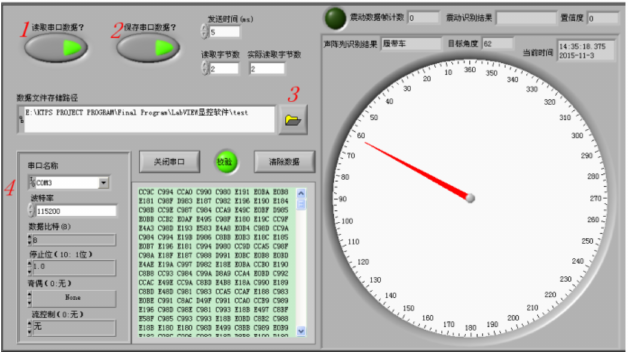
Figure 8. Control interface of real-time DOA and data acquisition.